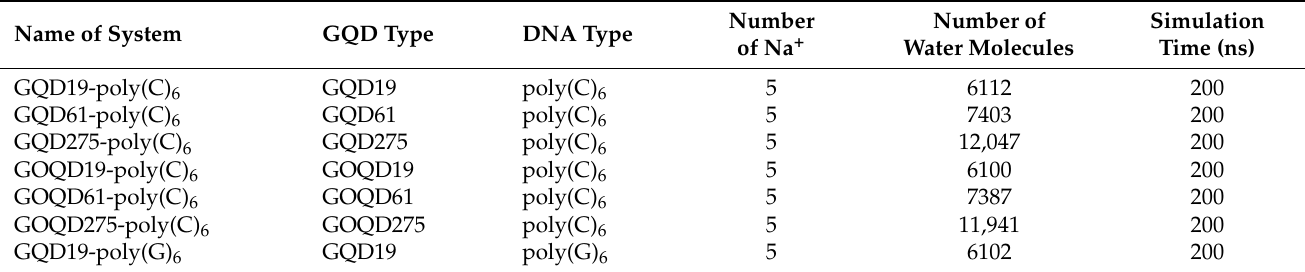
Table 1. The details of all simulated systems in this